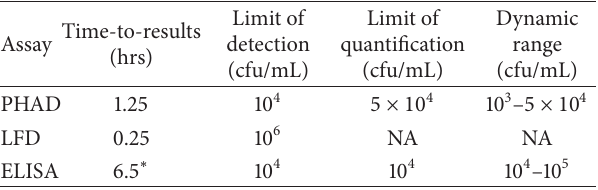
Table 1: Assay parameter comparison. Time-to-results Assay